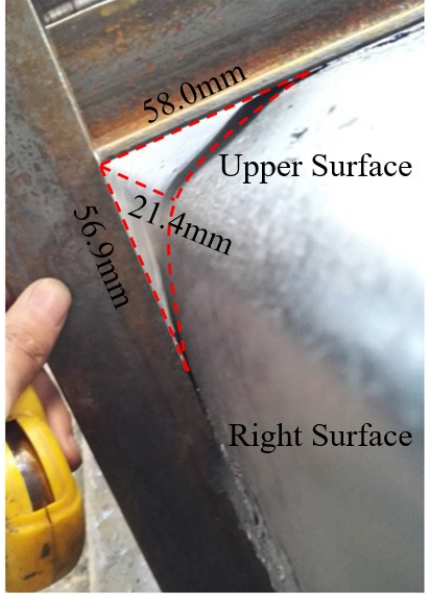
Figure 15. Corner depth diagram after corner cleaning in the factory.